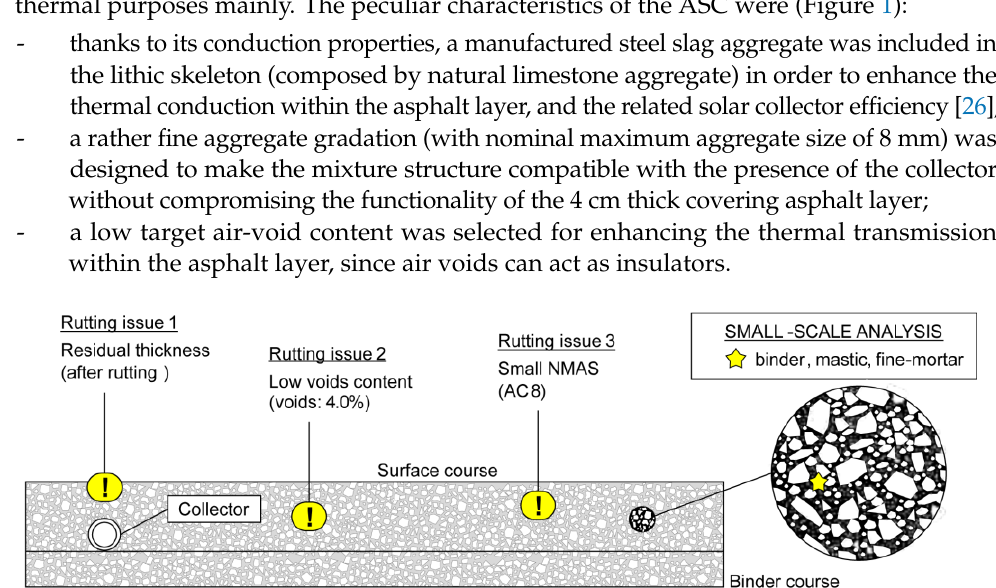
Figure 1. Background from the previous research [25].